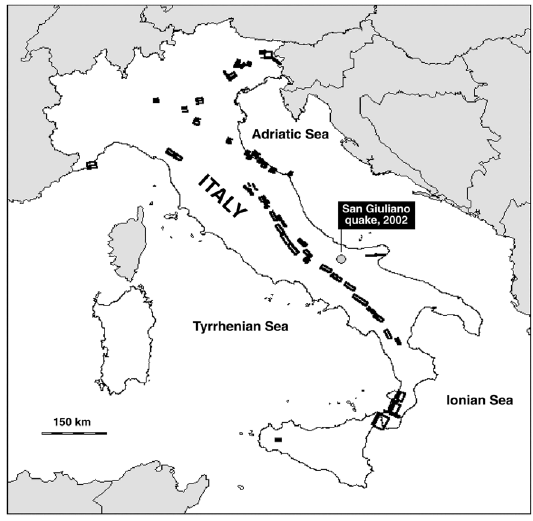
Fig. 1. Location of the geological/geophysical faults from the database of potential sources for earthquakes with magnitude greater than 5.5. (Valensise and Pantosti, 2001) with the location of the San Giuliano event.